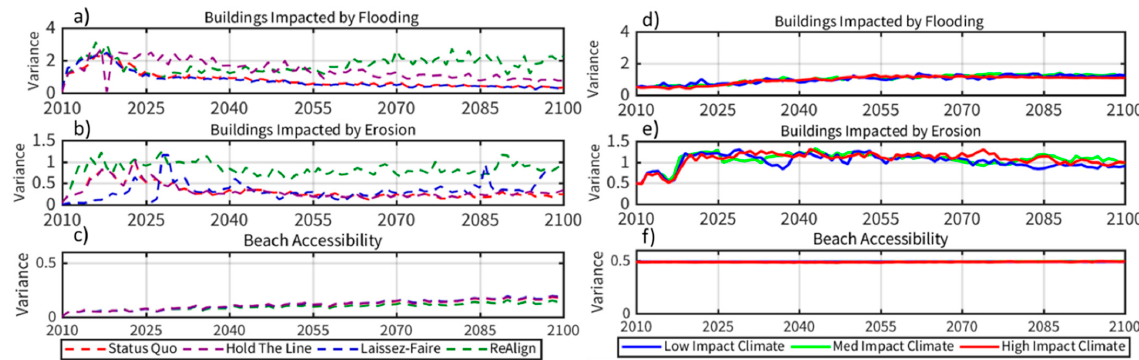
Figure 14. Coefficient of variance with respect to climate under each policy scenario (left, a – c ) and with respect to policy scenarios under a high-, medium-, and low-impact climate scenario (right, d – f ).